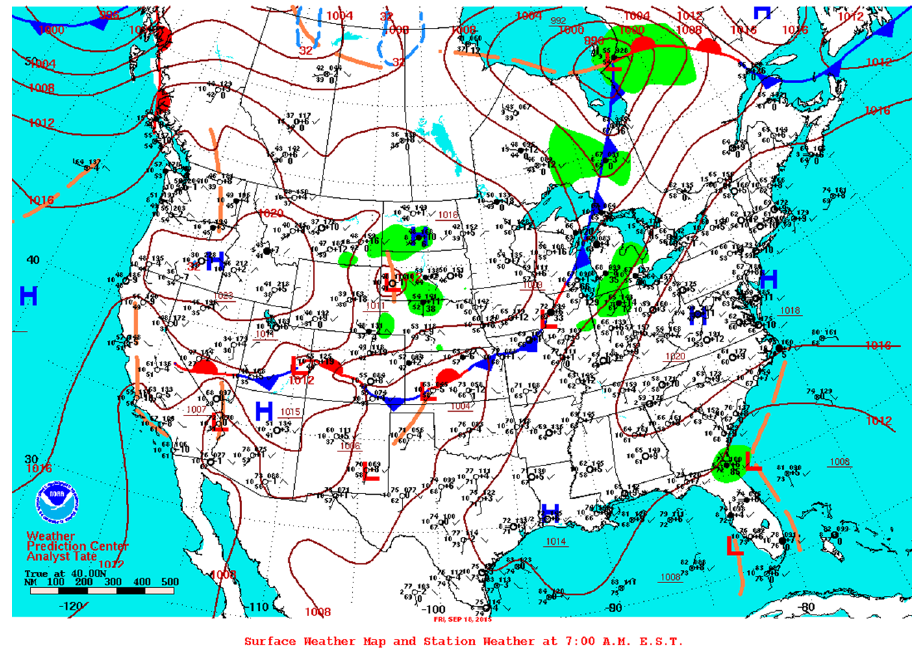
Figure 5. Surface map for the United Sates from 1200 UTC 18 September 2015 obtained from the US Daily Weather Map series [36].